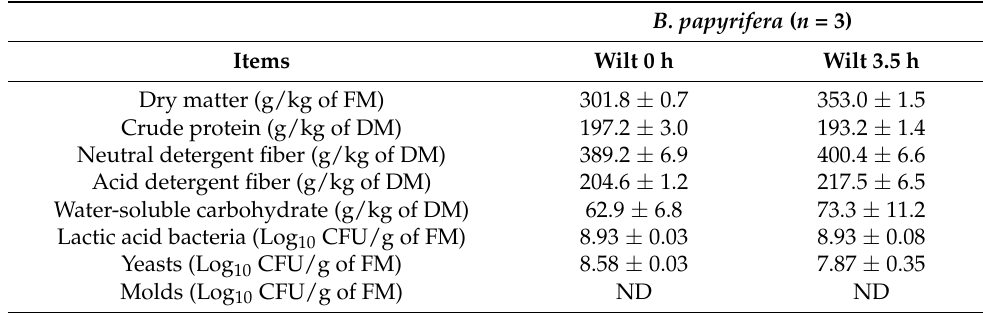
Table 1. Chemical composition and microbial population of B. papyrifera before ensiling.